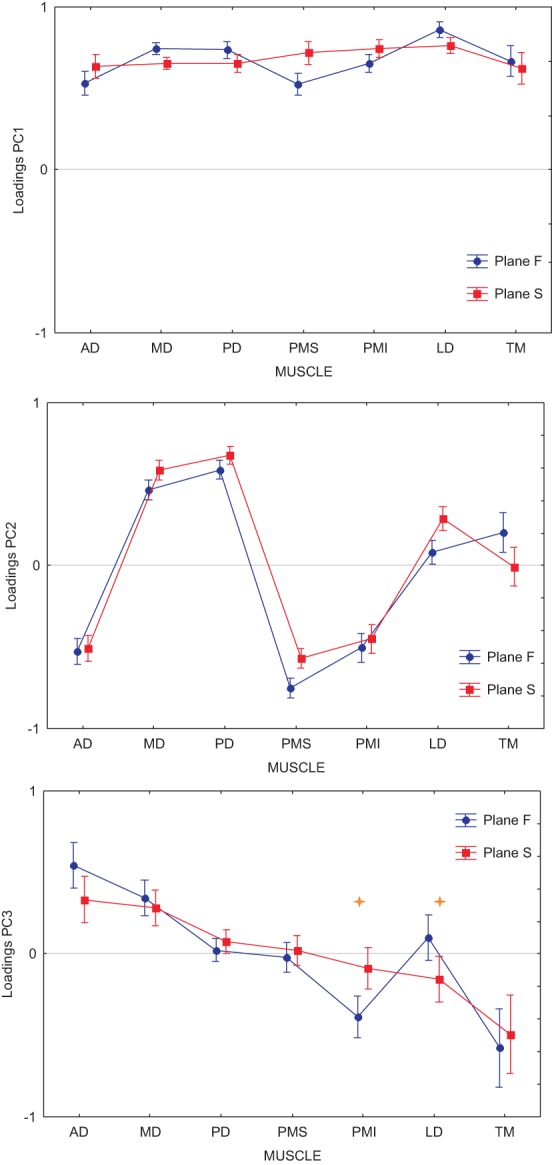
Average loadings for each PC and each muscle, computed for each of the two movement planes. Each graph shows the loading for Anterior Deltoid (AD), Medial Deltoid (MD), Posterior Deltoid (PD), Pectoralis Major Superior (PMS), Pectoralis Major Inferior (PMI), Latissimus Dorsi (LD), and Teres Major (TM). In blue are represented the loadings for movements performed in the frontal workspace, in red the loadings for movements performed in the sagittal workspace. Stars show loading for individual muscles that were significantly different between the frontal and sagittal planes (p < 0.001).